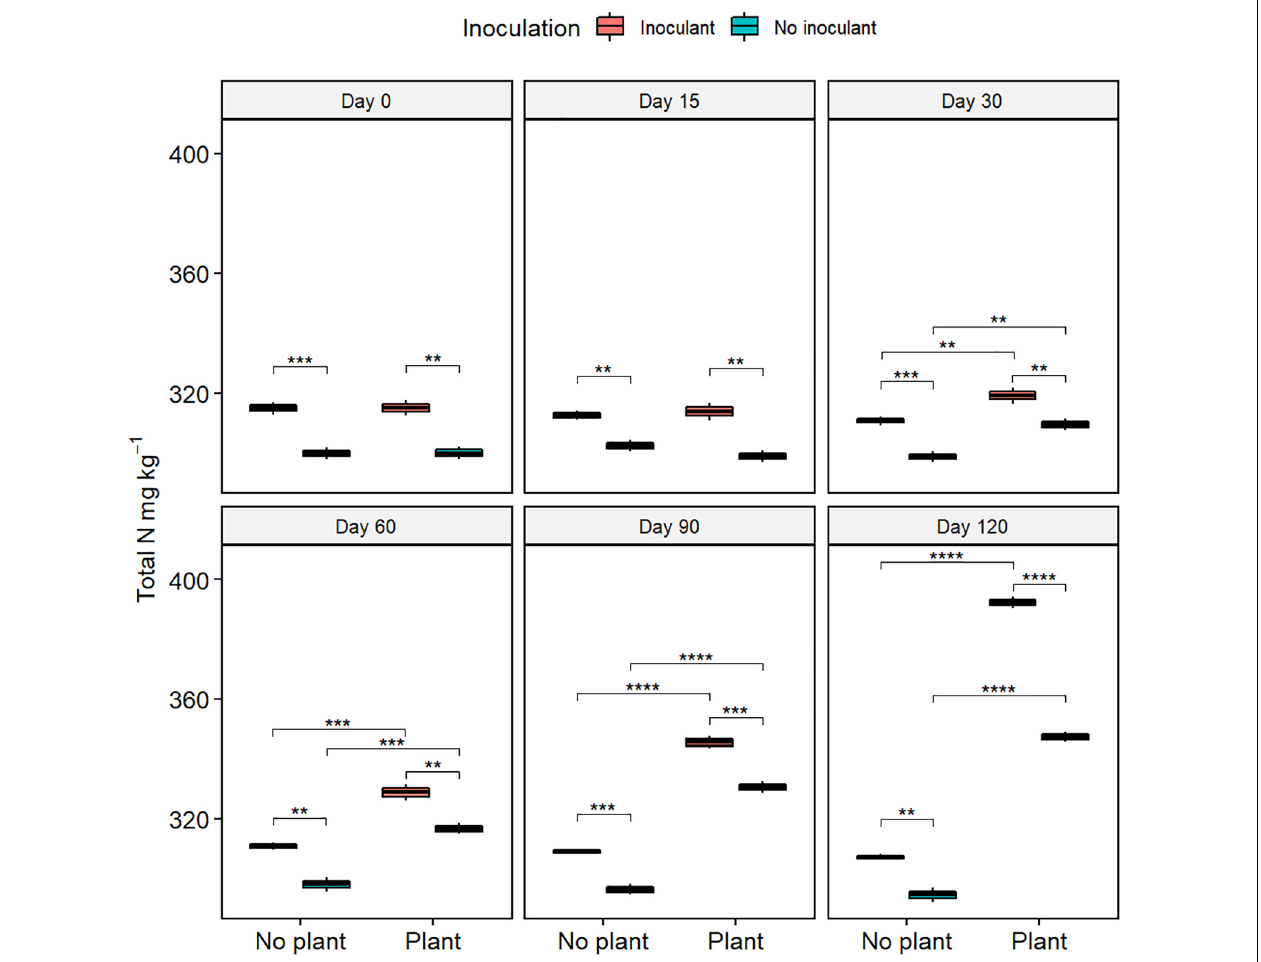
FIGURE 3 | Total nitrogen (TN) content in waste drill cuttings (WDCs). WDCs were incubated in a greenhouse for 120 days with and without black locust ( Robinia pseudoacacia ) plant and with or without bacterial and fungal consortium inoculant. Statistically significant differences are indicated with asterisks: ** P < 0.01; *** P < 0.001; **** P < 0.0001. The boxes show mean, lower and upper hinges indicate the first and third quartiles, and the whiskers indicate the ranges 1.5 times the interquartile